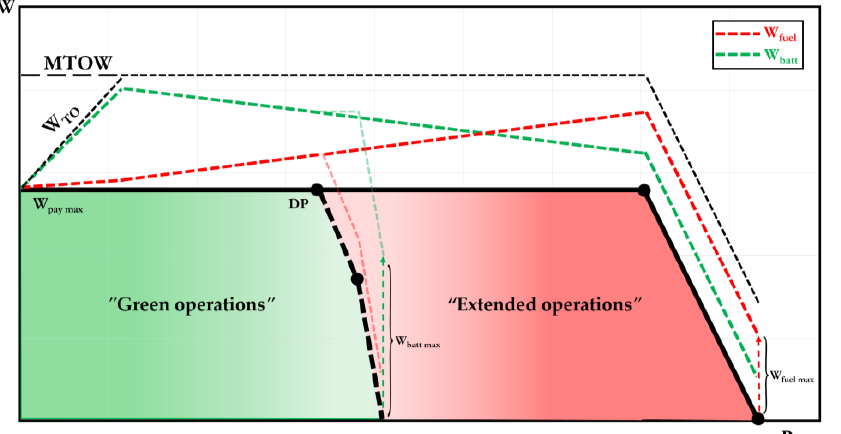
Figure 23. Extended operations shape for the payload – range diagram of a hybrid-electric aircraft.